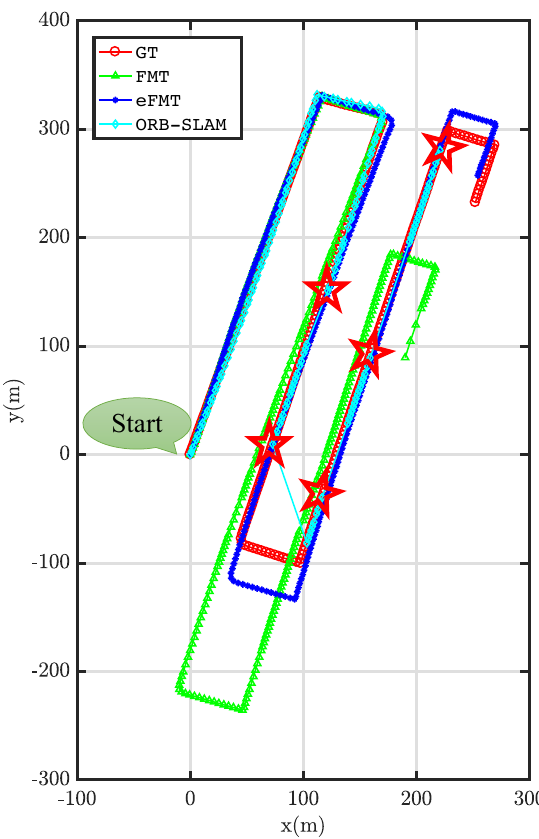
Figure 12. Overall trajectories of different methods on the UAV dataset. ORB-SLAM3 fails several times, as indicated by the red stars. These sub trajectories of ORB-SLAM3 are aligned manually for visualization. SVO and DSO fail to track the images.